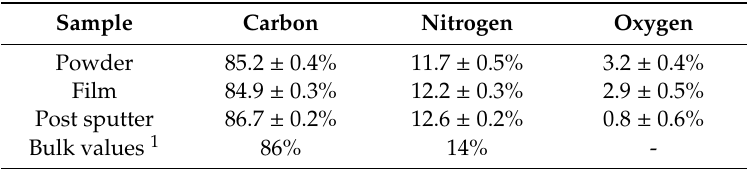
1 Based on atomic structure.